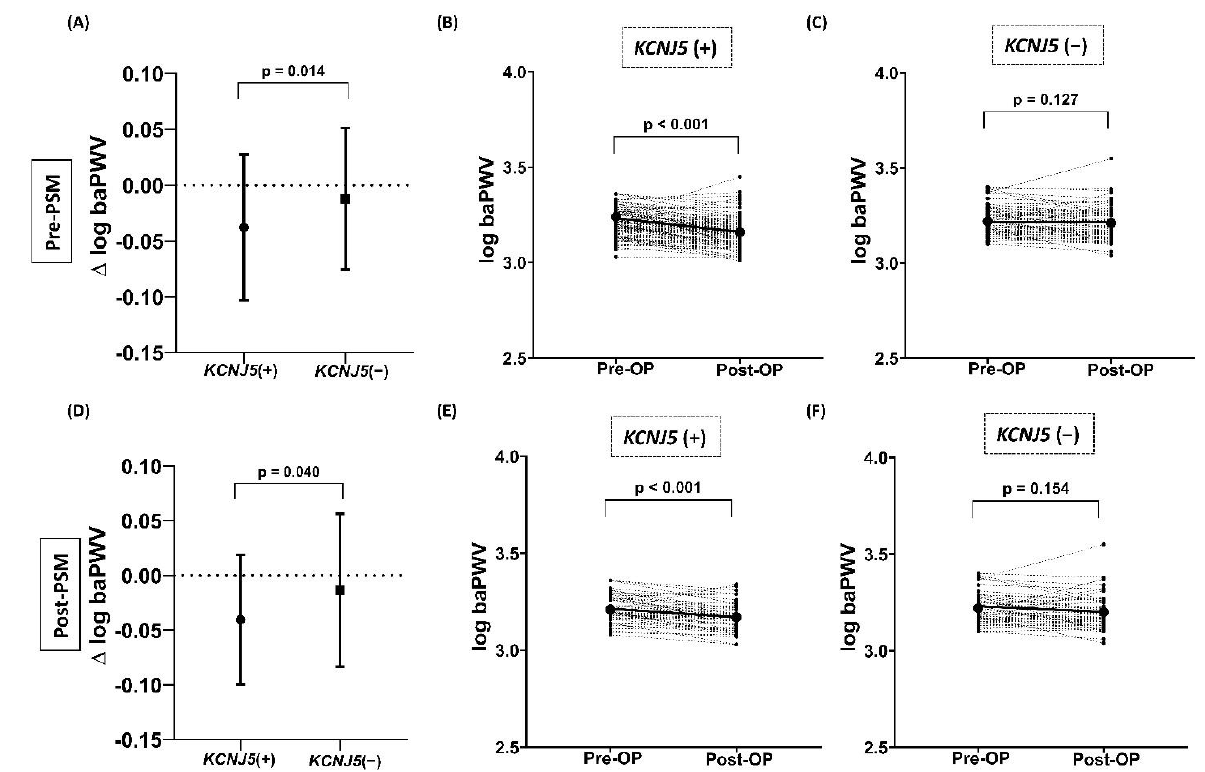
Figure 1. The changes in log baPWV after adrenalectomy between the APA patients with and without KCNJ5 mutations before and after PSM. ( A ) Before PSM, the decrease in log baPWV after adrenalectomy was significantly greater in the patients with KCNJ5 mutations than in those without mutations. ( D ) Even after PSM, the decrease in log baPWV after adrenalectomy was still significantly greater in the patients with KCNJ5 mutations than in those without mutations. ( B , C ) Before PSM, only the patients with KCNJ5 mutations had a significant decrease in log baPWV, and this was not seen in the patients without KCNJ5 mutations. ( E , F ) After PSM, still only the patients with KCNJ5 mutations had a significant decrease in log baPWV, and again this was not seen in the patients without KCNJ5 mutations. APA, aldosterone-producing adenoma; baPWV, brachial–ankle pulse wave velocity.